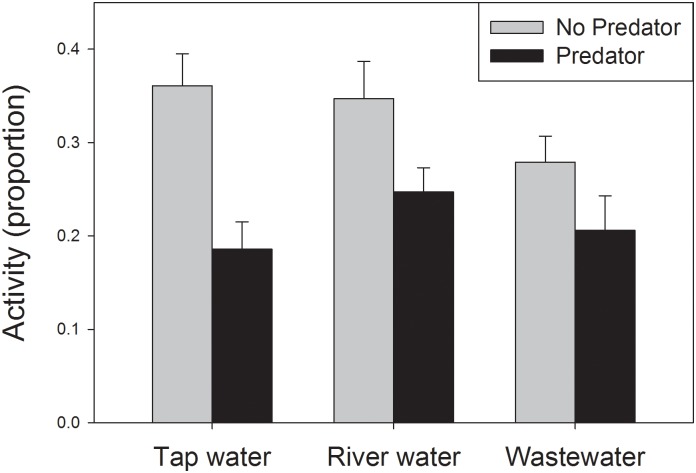
Effect of predator cues on activity of gray treefrog tadpoles.Tadpoles were housed in water drawn from three sources. Activity was scored as mean proportion of individuals that moved during 20-second observation bouts. Response to predator cues depended on water source. Bars represent one standard error, N = 16 replicates per treatment combination.